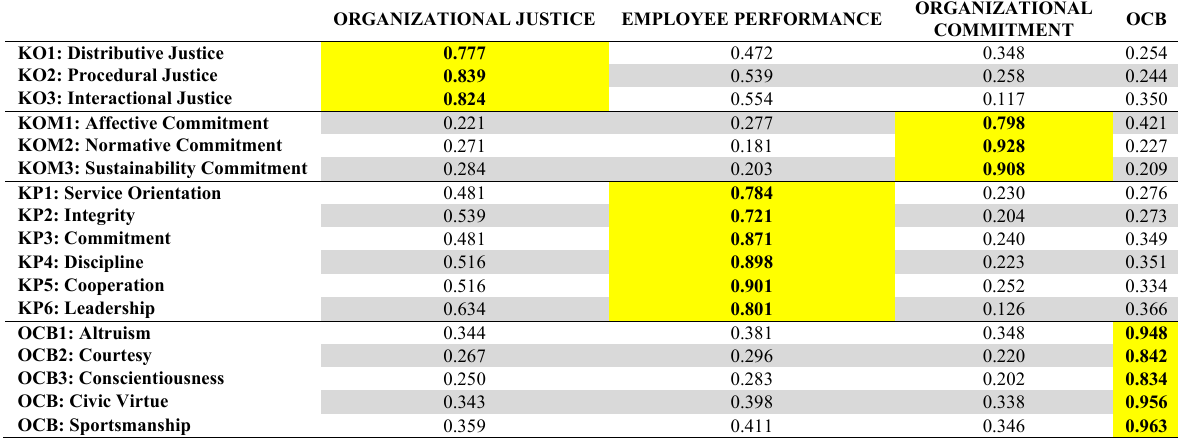
Discriminant Validity